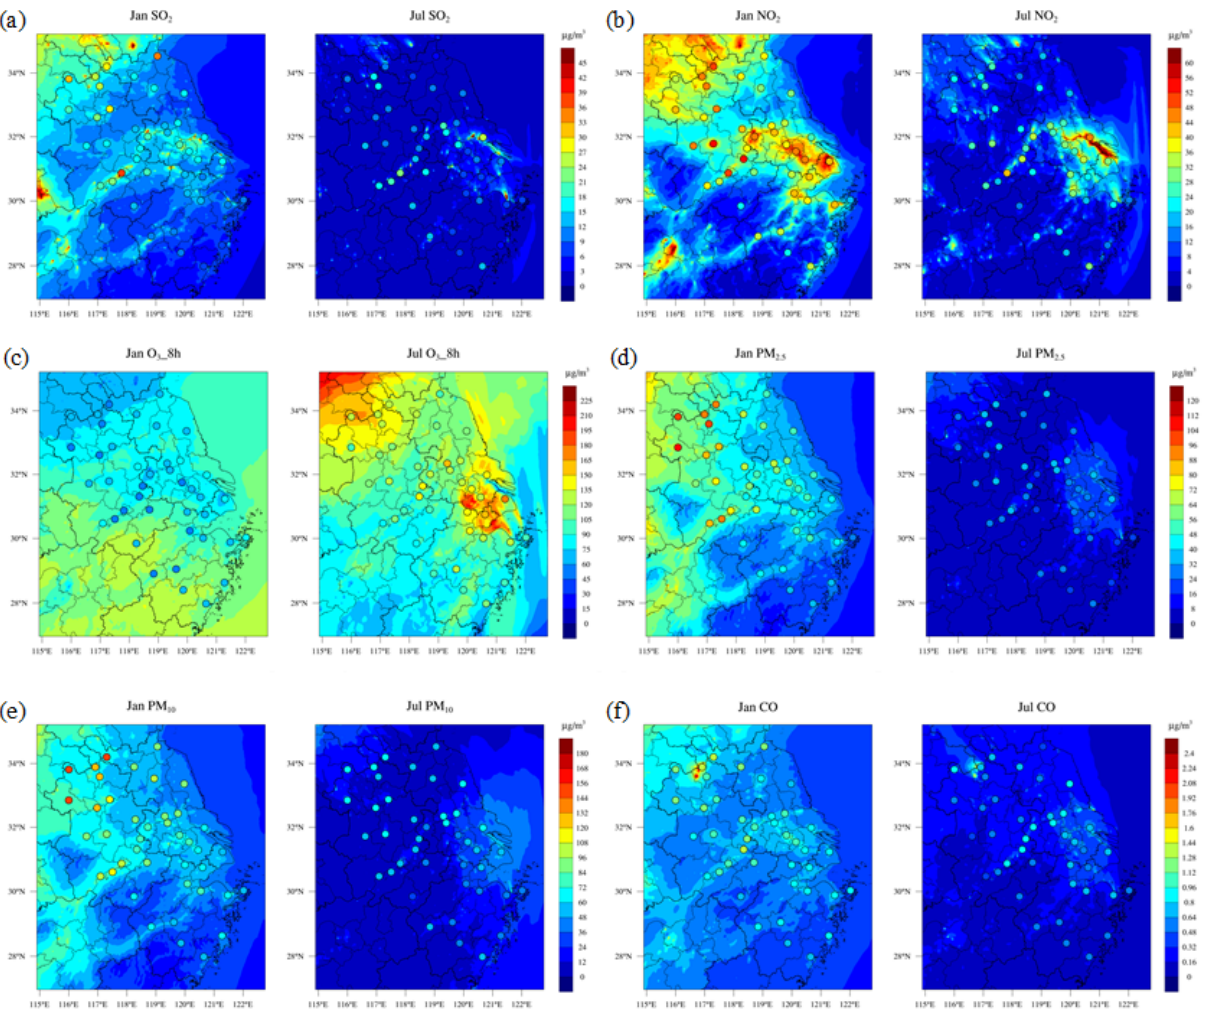
Figure 8. Comparisons of simulated and observed (circles) monthly average pollutant concentrations for cities in the YRD region in January and July 2017: (a) SO 2 , (b) NO 2 , (c) daily maximum 8h O 3 (O 3 _8h), (d) PM 2 . 5 , (e) PM 10 , and (f) CO.